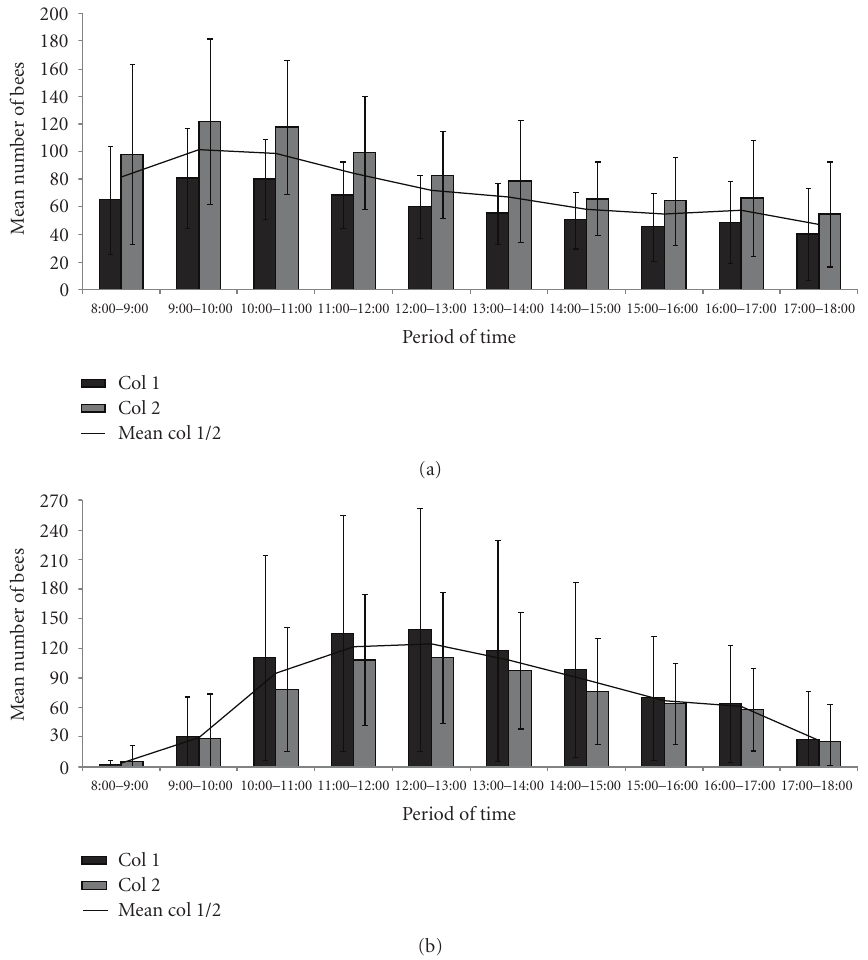
Figure 2: Total of entrances in two colonies of Plebeia remota in the reproductive phase (a) and in the diapause